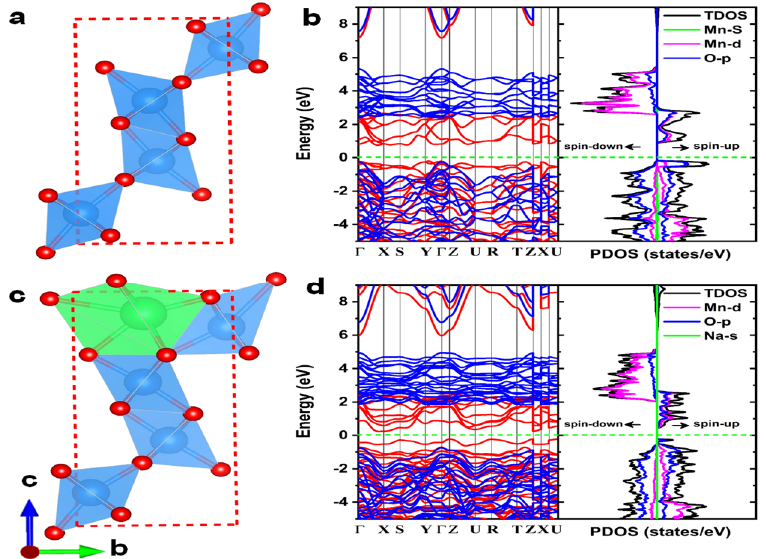
Figure 7. The electronic band structure, the spin-polarized total density of states (TDOS), and partial density of states (PDOS) plotted together with corresponding optimized structures of ( a , b ) pure MnO 2 ; and ( c , d ) Na-doped MnO 2 ; The spin-up ( ↑ ) and spin-down ( ↓ ). To analyze the charge transfer and charge population, Figure 8, bader charge calcula- tions were performed according to the following equation.